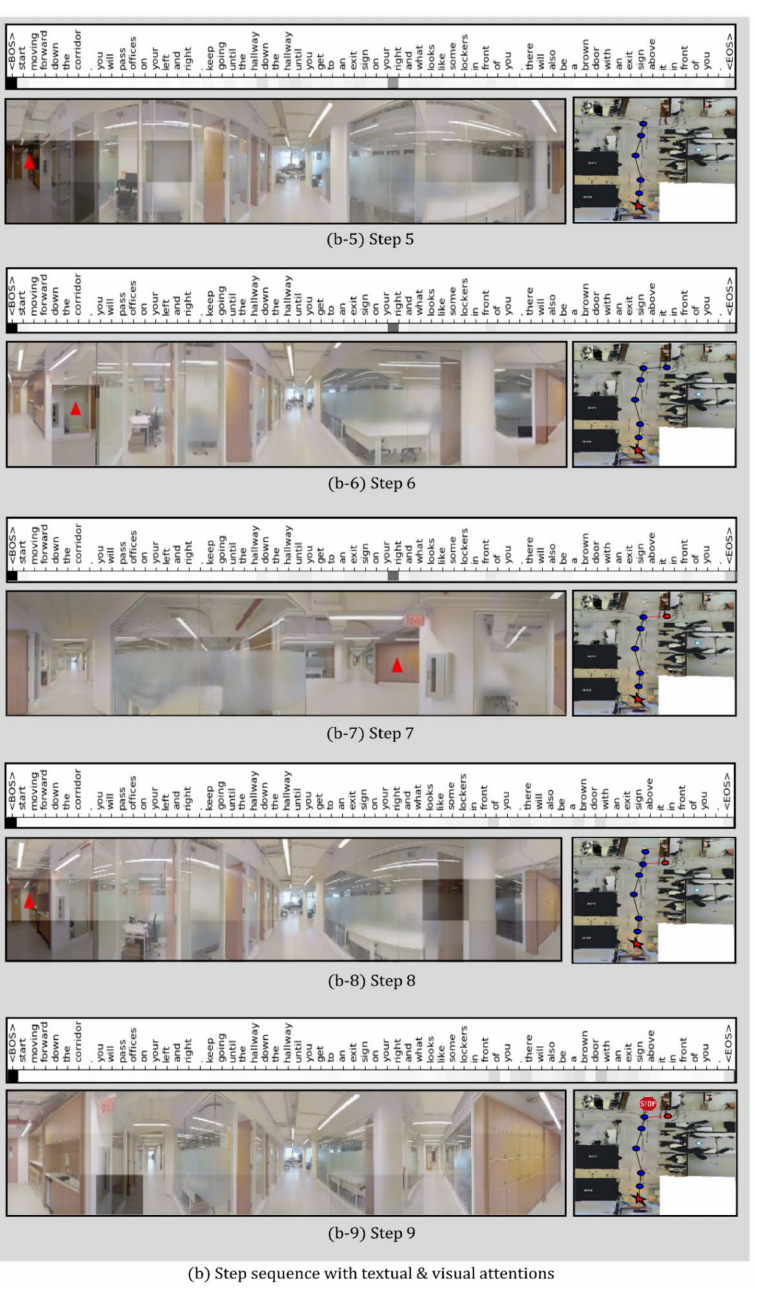
Figure 13. Second example of VLN task executed by the proposed model JMEBS: Step